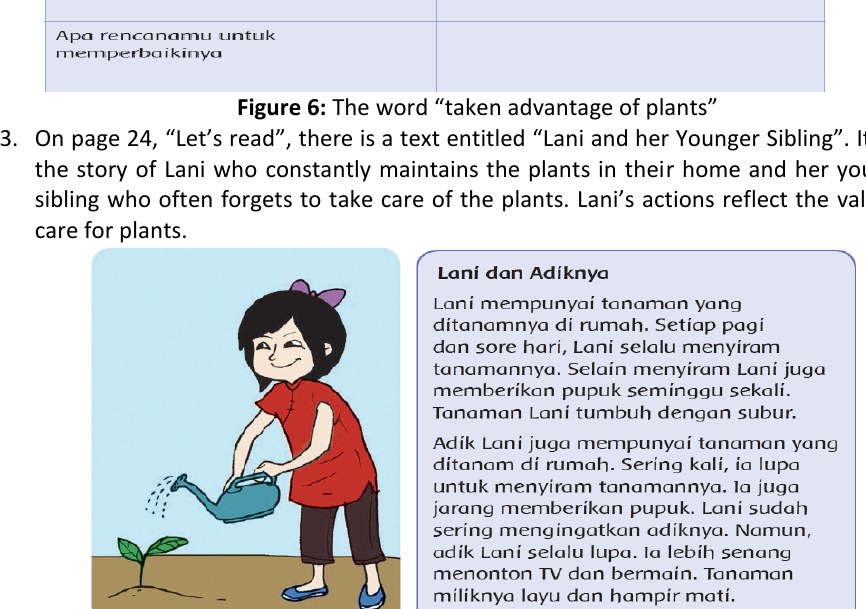
Figure 7: The text “Lani and her younger sibling”